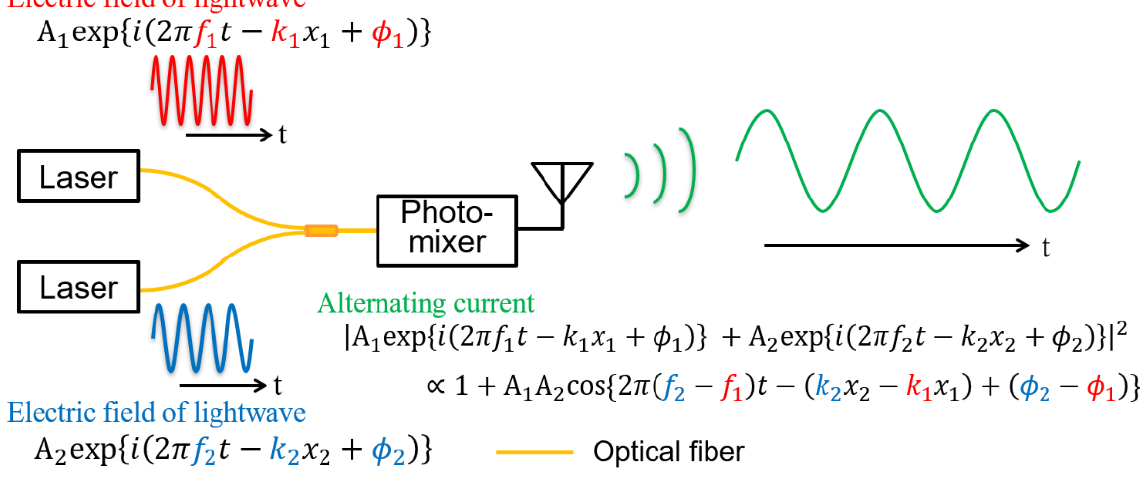
Figure 2. Photomixing system.